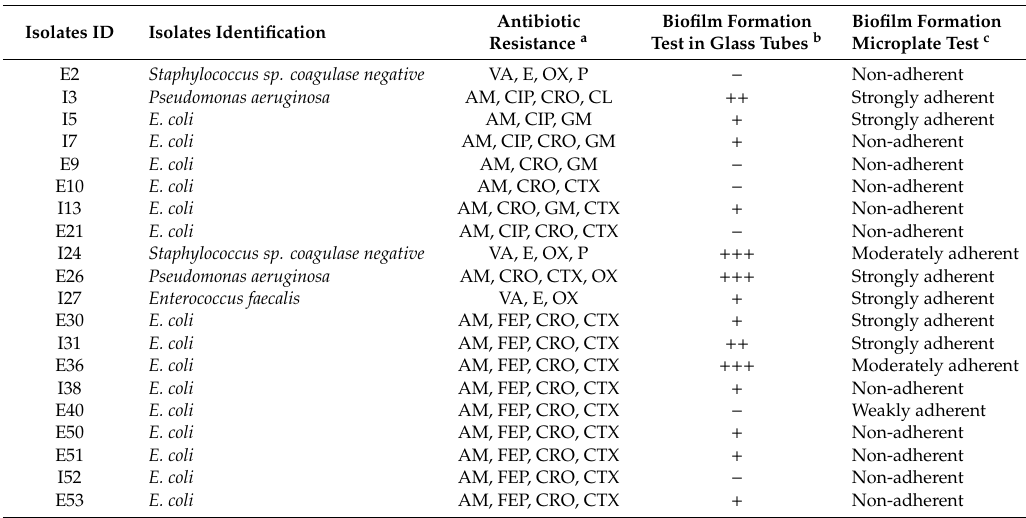
Table 1. Multidrug-resistant clinical isolates from UTI patients and biofilm formation based on the glass tube qualitative test and the quantitative test in a microplate.